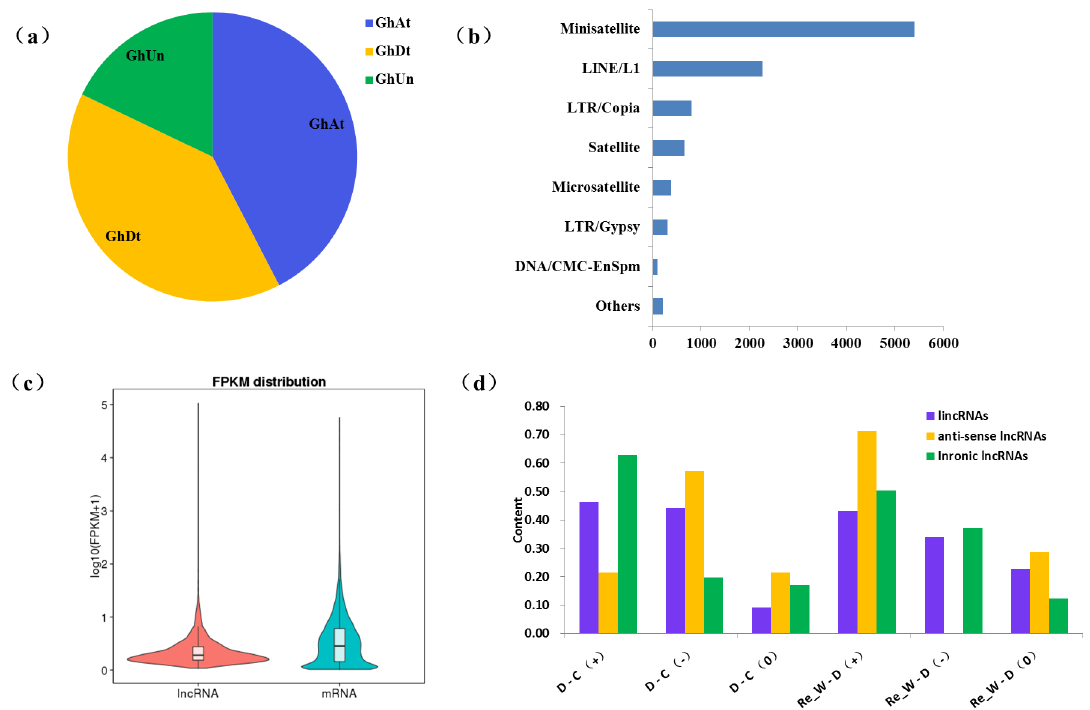
Fig 3. Transposable elements (TEs) prediction and expression patterns analysis of lncRNAs. (a) The results of repeat sequences and transposable elements (TEs) prediction. GhAt, GhDt and GhUn represent A subgroup, D subgroup and ungrouped, respectively. (b) The faction of lncRNAs with different characteristics. (c) Overall expression levels difference between lncRNAs and mRNAs. (d) Expression patterns analysis of different lncRNAs in response to the drought stress. D-C, Re_W-D means drought vs control, Re-Watering vs drought, respectively and +, - represents up-regulated and down- regulated, respectively.